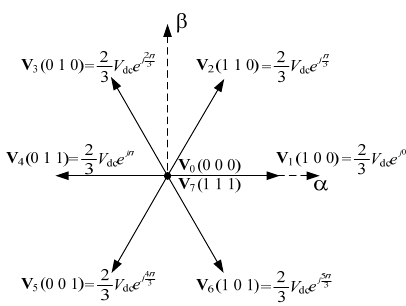
Figure 2. Voltage vectors generated by the voltage source inverters (VSIs).